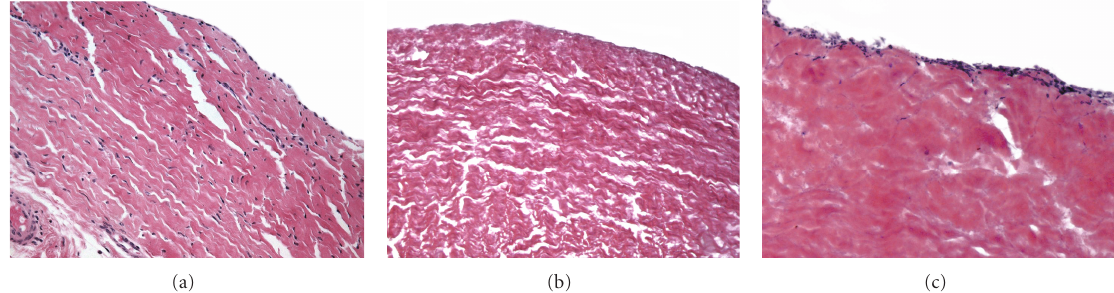
Figure 4: H and E staining of native bovine pericardium (a); TriCol-decellularized bovine pericardium before (b) and after 7 days of bovine fibroblasts seeding (c). Magnification